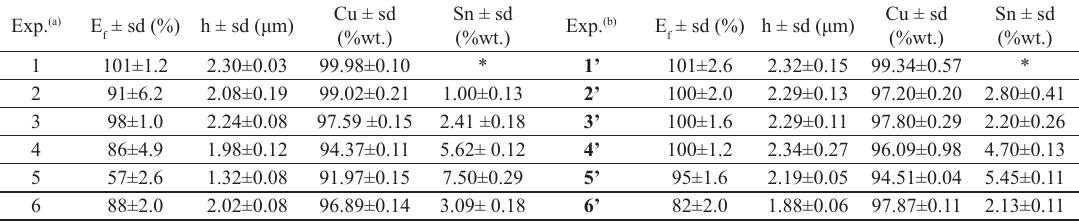
, %) , calculated thickness (h, μm), and copper and tin contents Table 3. Average values ± standard deviation (sd) of current efficiency (E f (%wt. Cu and %wt. Sn) in the coatings produced at different j values ( Table 2), using DC and SPC. Cu ± sd Exp. (a) E ± sd (%) h ± sd (μm) f